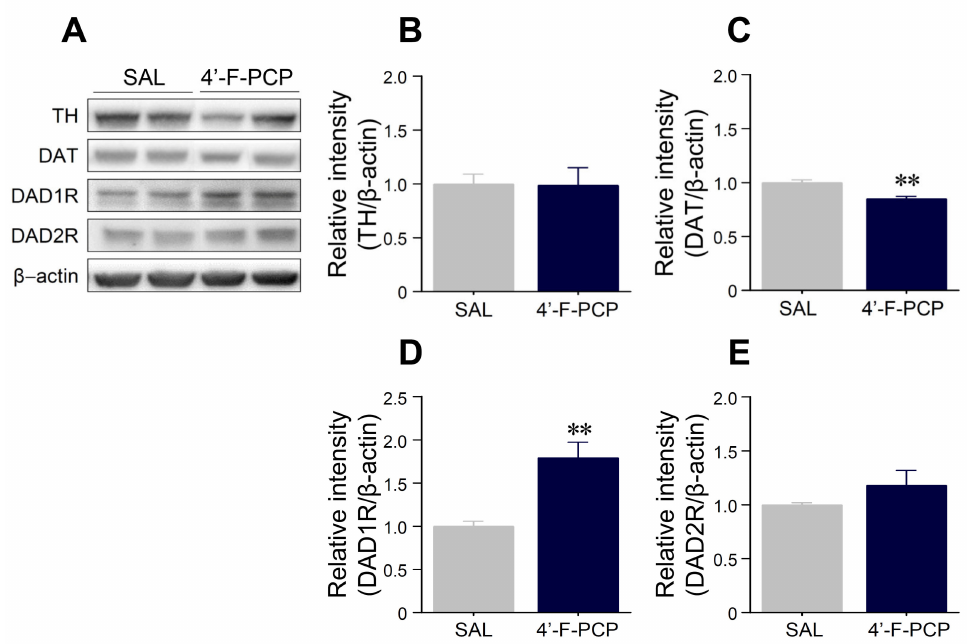
Figure 5. E ff ect of 4 (cid:48) -F-PCP on the immunoreactivities of dopamine-related proteins in the nucleus accumbens (NAc) of 4 (cid:48) -F-PCP-self-administered rats under the PR schedules. ( A – E ) Immunoreactivities of TH, DAT, DAD1R, and DAD2R proteins in the NAc after saline or 1.0 mg / kg / infusion 4 (cid:48) -F-PCP self-administration under the PR schedules of reinforcement. Asterisks ** indicate p < 0.01 vs. saline controls. SAL: saline. n = 4–6 per